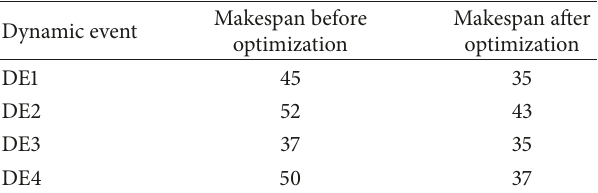
Table 9: Comparisons of dynamic